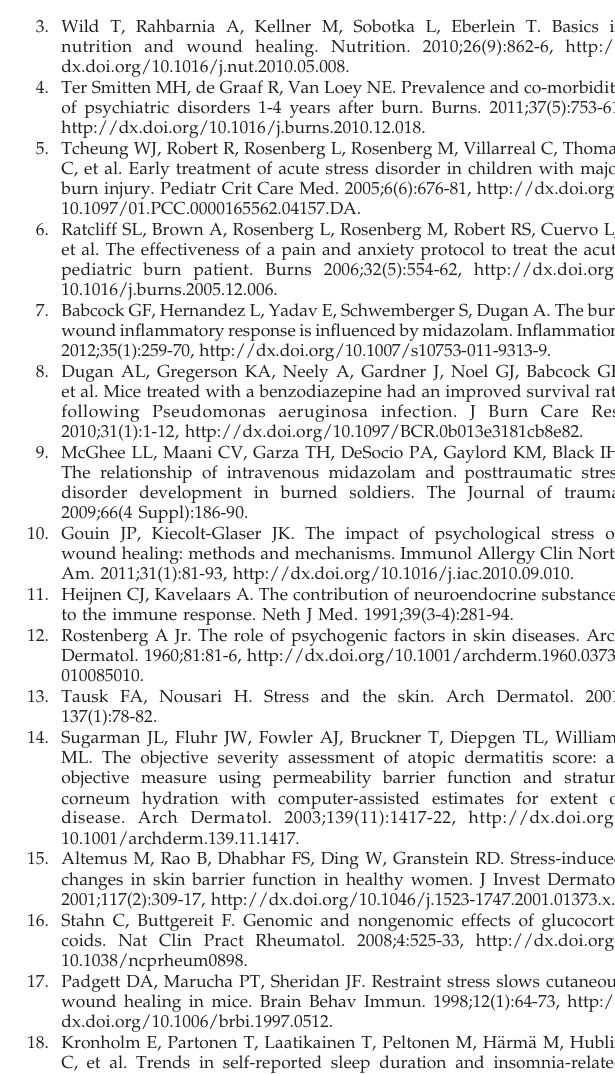
Figure 1 - The proposed model for the interplay between the use of BZD and healing in patients with skin lesions. In this case, the immune system and healing continue to be mutually dependent and are presented in relation to the bidirectional immune profile and psychological profile of the patient because large lesions cause anxiety and stress, and these effects directly affect healing and inflammatory capacity. Finally, BZD compounds are ultimately responsible for alterations in healing and